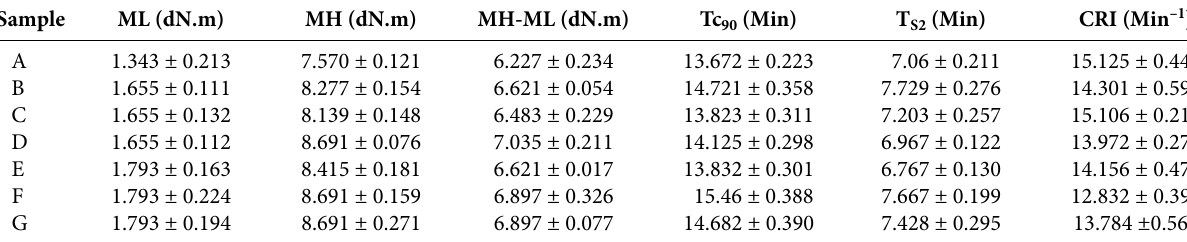
Table 3. The results of curing behavior of rubber compounds.